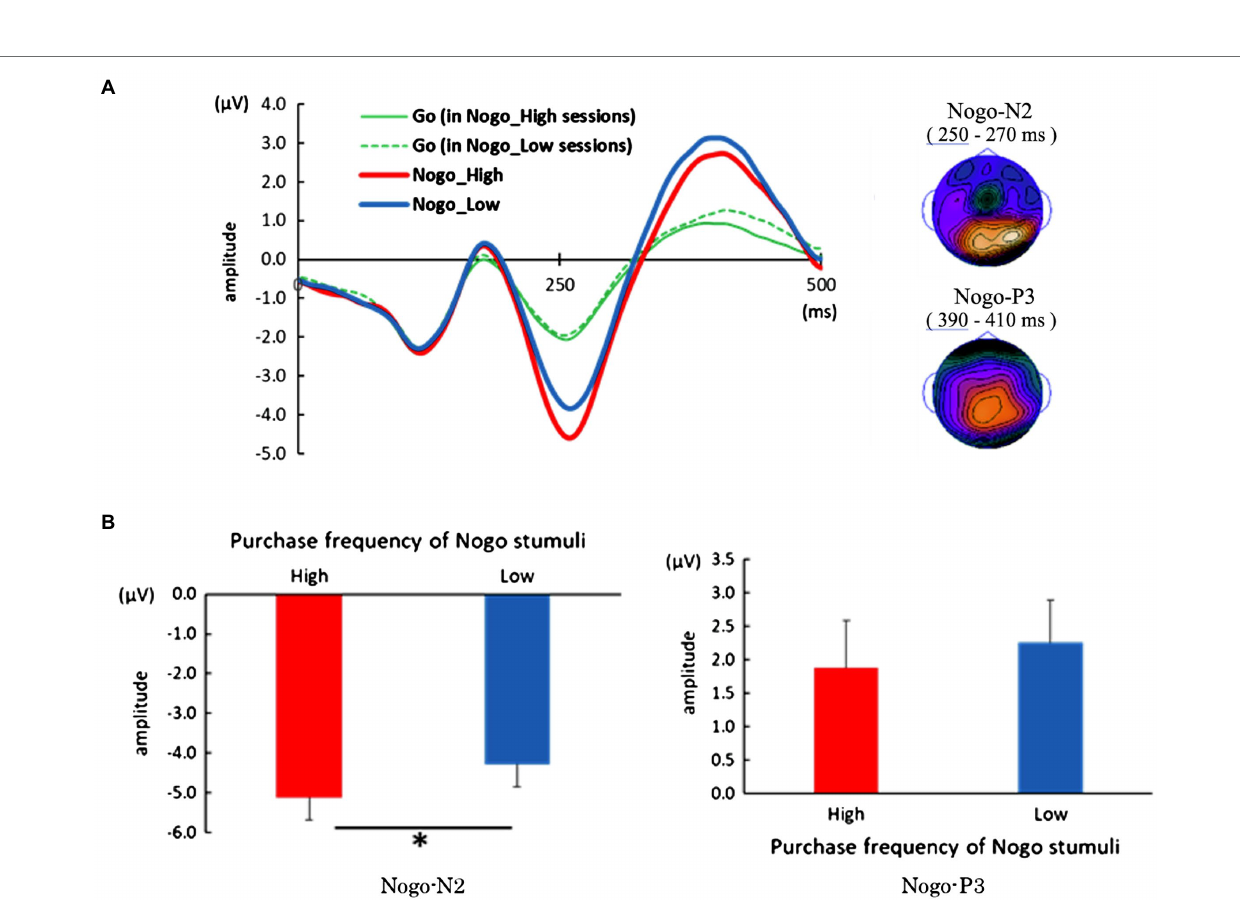
FIGURE 3 | Event-related potential (ERP) analysis of Go/No-go task. (A) Left: An averaged waveform of ERP which was time-locked on the presentation of stimuli. Typical No-go-N2 and No-go-P3 components can be seen. Right: Topographical distribution of No-go-N2 and No-go-P3 components. A pronounced negative and positive distribution can be observed in the parietal area at the time corresponding to the No-go-N2 and No-go-P3 components, respectively. (B) Results of paired t -test of the peak amplitude of No-go-N2 (left panel) and No-go-P3 (right panel). No-go trials with high purchase frequency products elicited significantly greater No-go-N2 amplitudes. Error bars in both panels represent standard error of the mean. * Significant on p <